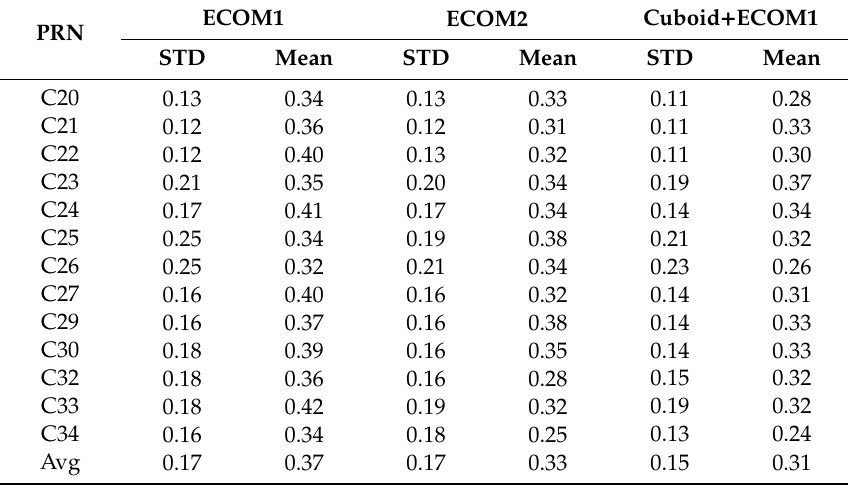
Table 10. The precision of the 48 h clock overlapping. The unit is